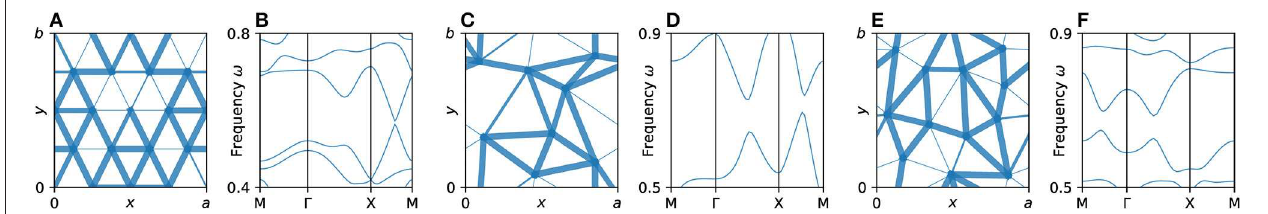
FIGURE 1 | Bandgap tuned networks and topological band structures. (A) Tuned spring stiffnesses (indicated by line thickness) on the basis of triangular grids with 4 4 unit cells were tuned to have band gaps. (B) The final band structures exhibit band shapes reminiscent of band inversion. (C,E) Tuned network on top of a × topology based on the Delaunay triangulation of a randomized point set. (D,F) The band structure again appears to exhibit band inversion. All three networks undergo a topological phase transition as time-reversal symmetry is